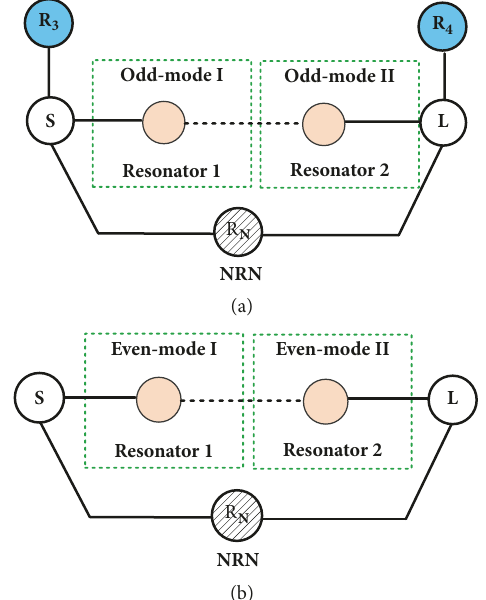
Figure 5: Coupling structure of the proposed dual-band bandpass filter. (a) At lower passband. (b) At upper passband.